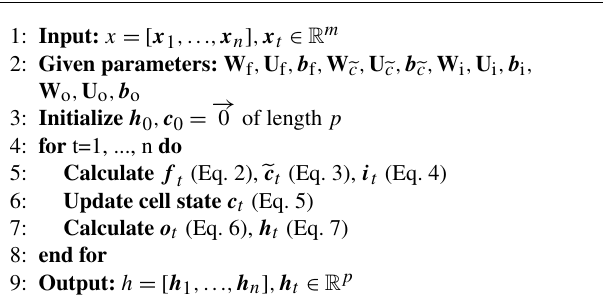
Algorithm 1 Pseudocode of the LSTM layer